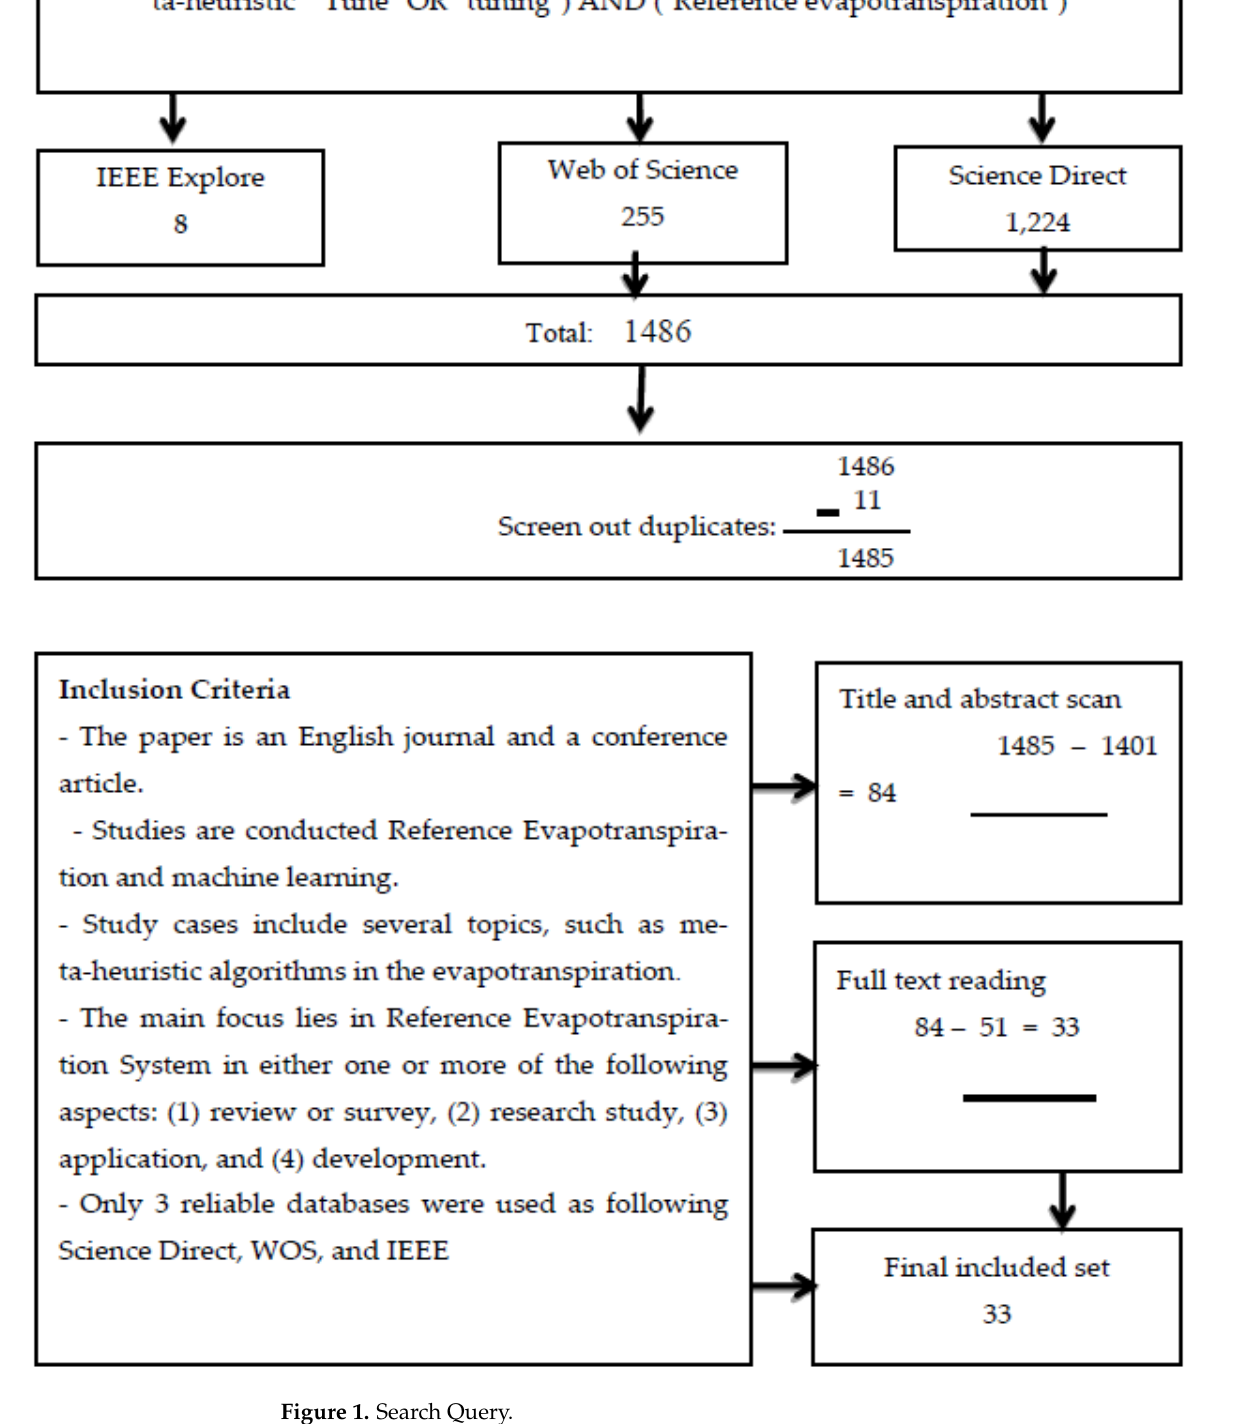
Figure 1. Search